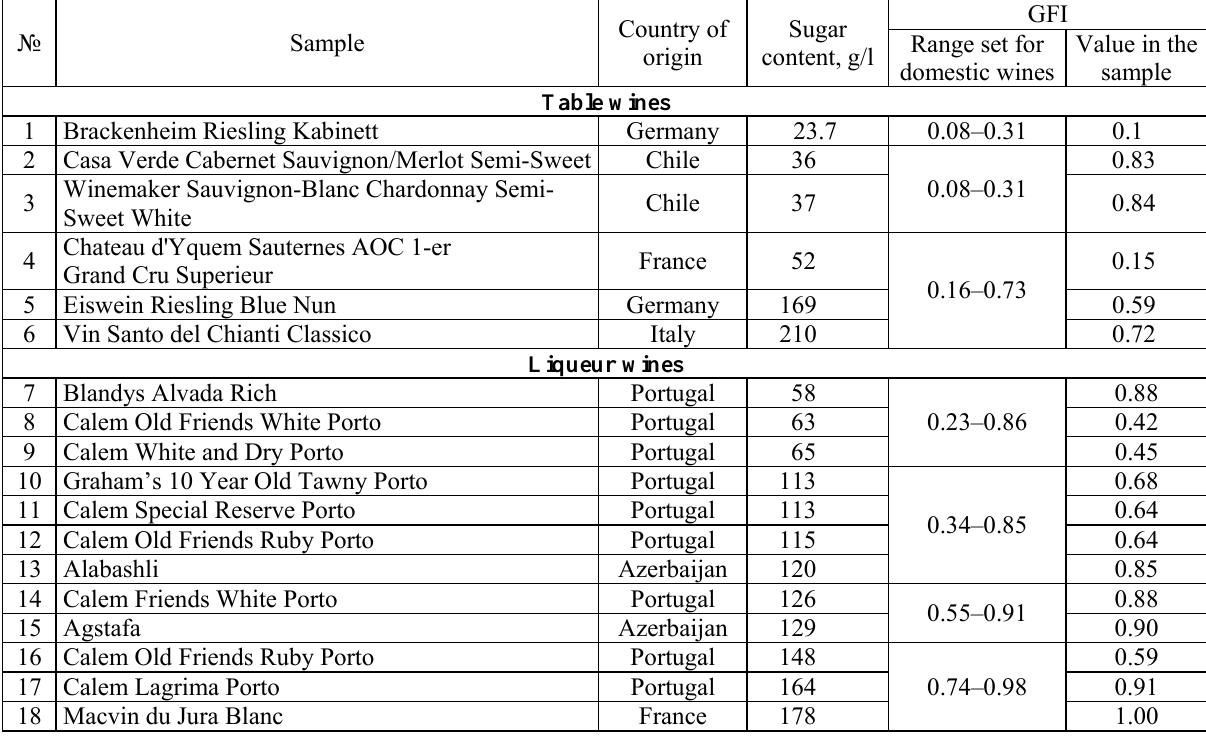
Table 5. Value of the glucose-fructose index (GFI) in imported wines №